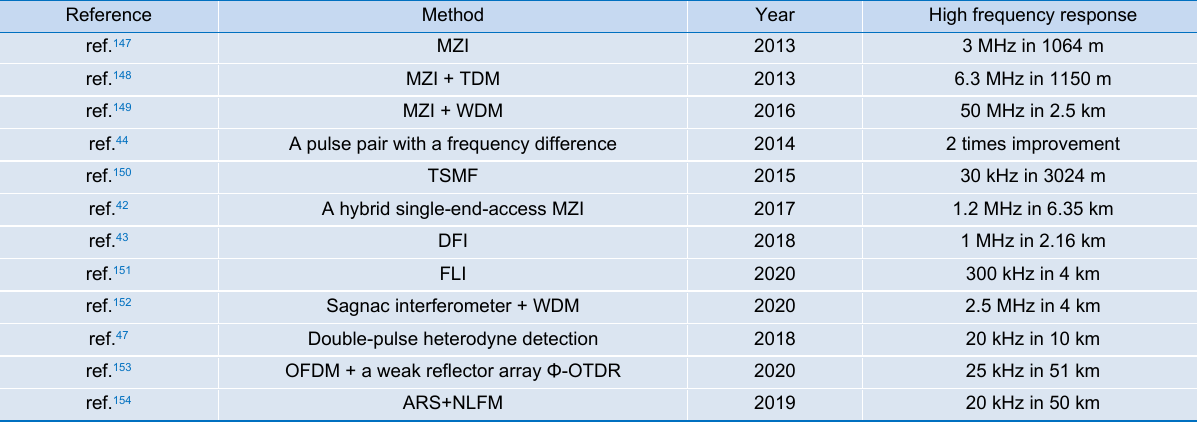
Table 3 | Research progress on improving frequency response range in Ф-OTDR